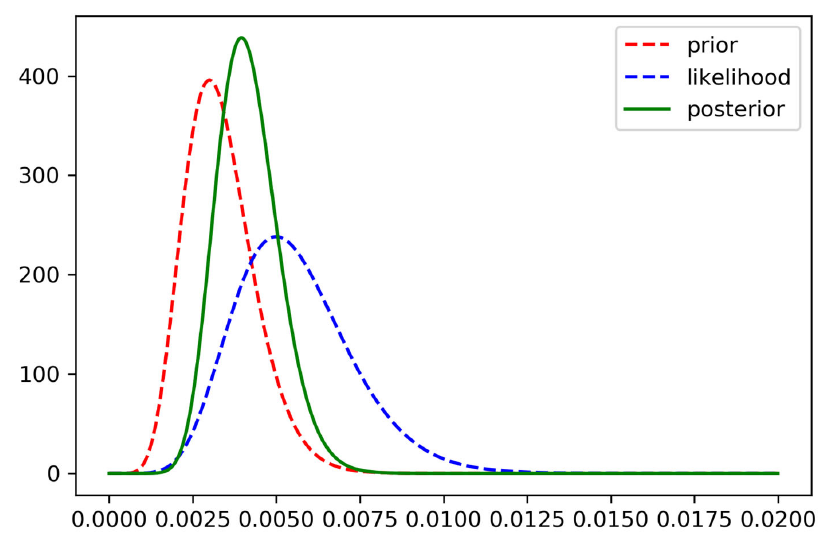
Figure 13. Bayesian estimate of ˆ d θ = 0.42% for COVID-19, with 95% confidence bands of [ 0.375%,0.75% ] . This is significantly lower than the WHO’s estimate of 3.14%. This is significantly lower than the WHO’s initial estimate of